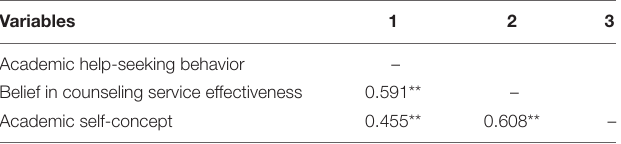
TABLE 2 | Relationship between study variables.